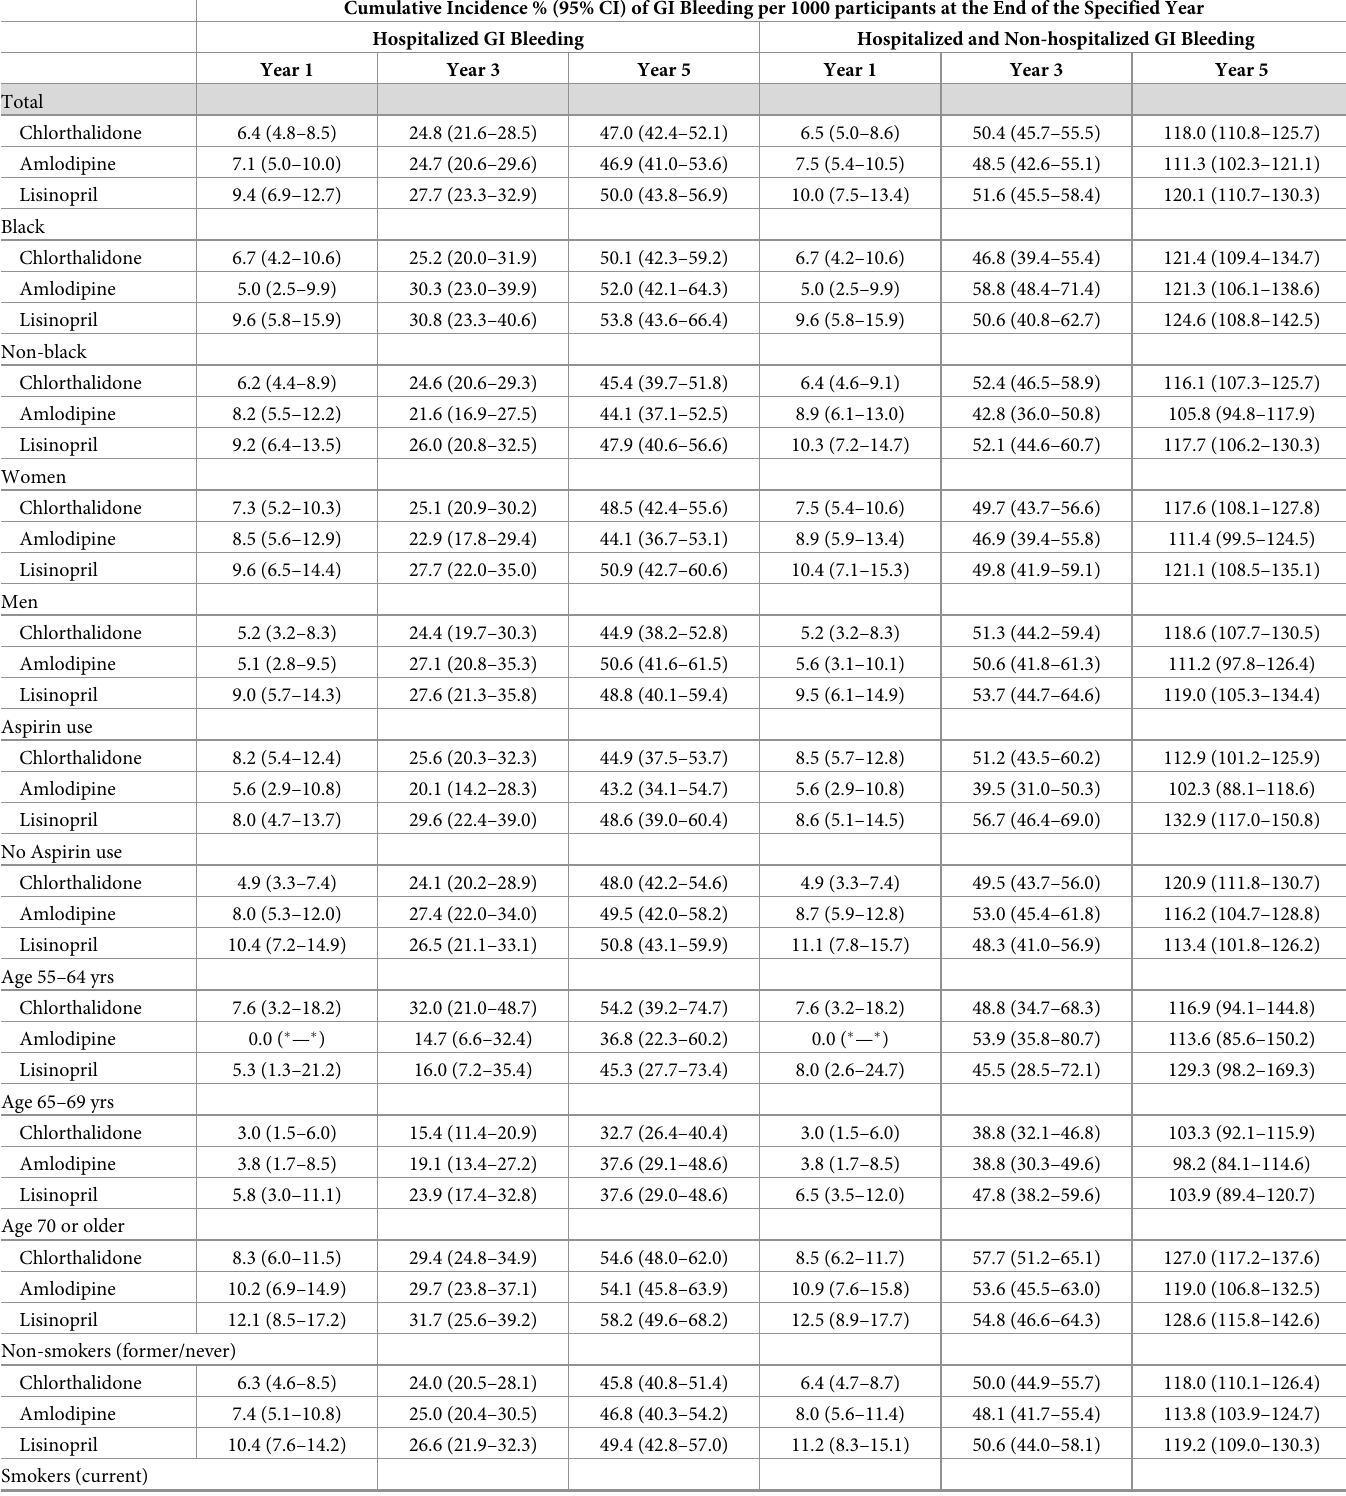
Table 4. Cumulative proportion of participants with GI bleeding by year, subgroup, and RCT